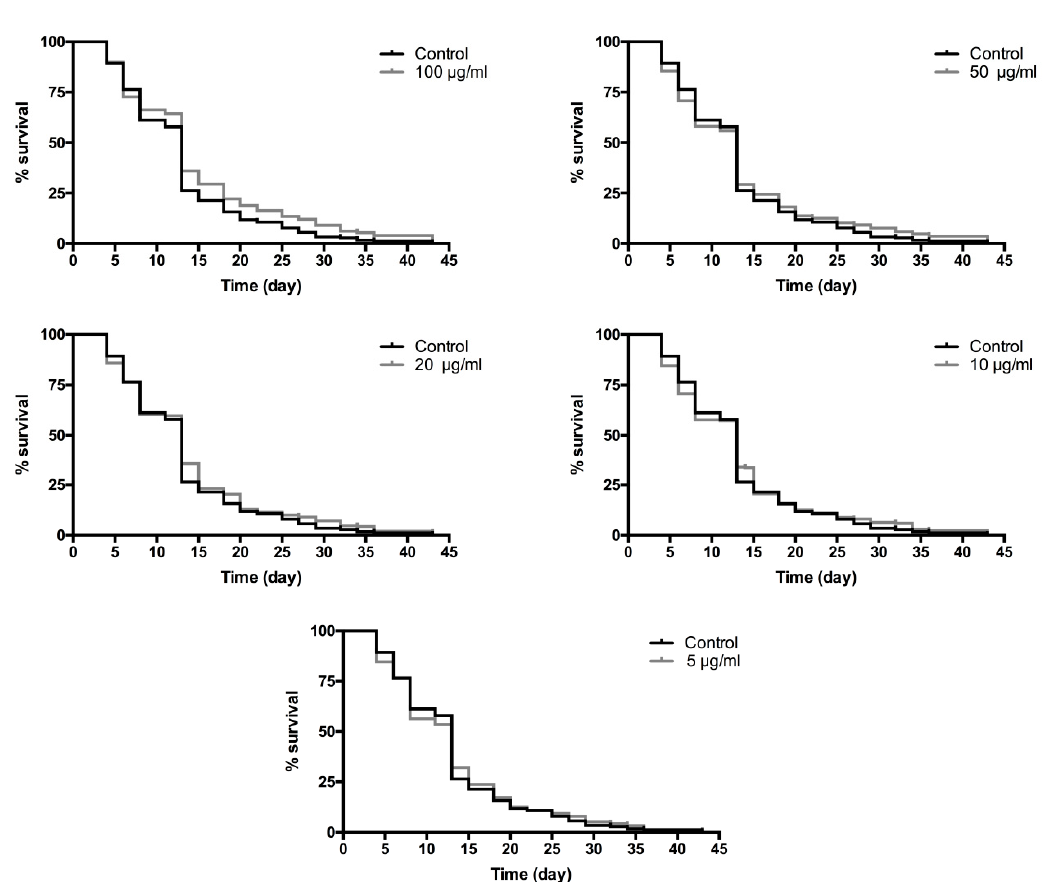
Figure 3. Lifespan curves of wild-type Caenorhabditis elegans (C. elegans) in a liquid medium supplemented with different concentrations of RT extract (0–100 µ g/mL) at 20 ◦ C. Synchronized worms were exposed to the extract from the second day of adulthood (day one). Scoring of survival was carried out three times per week until all worms died. The results are representative of three independent biological replicates. The curves were analyzed using a long-rank test. Differences in the survival curves between the treatment and control groups were found at the dose of 100 µg/mL, with a p -value of 0.0153.